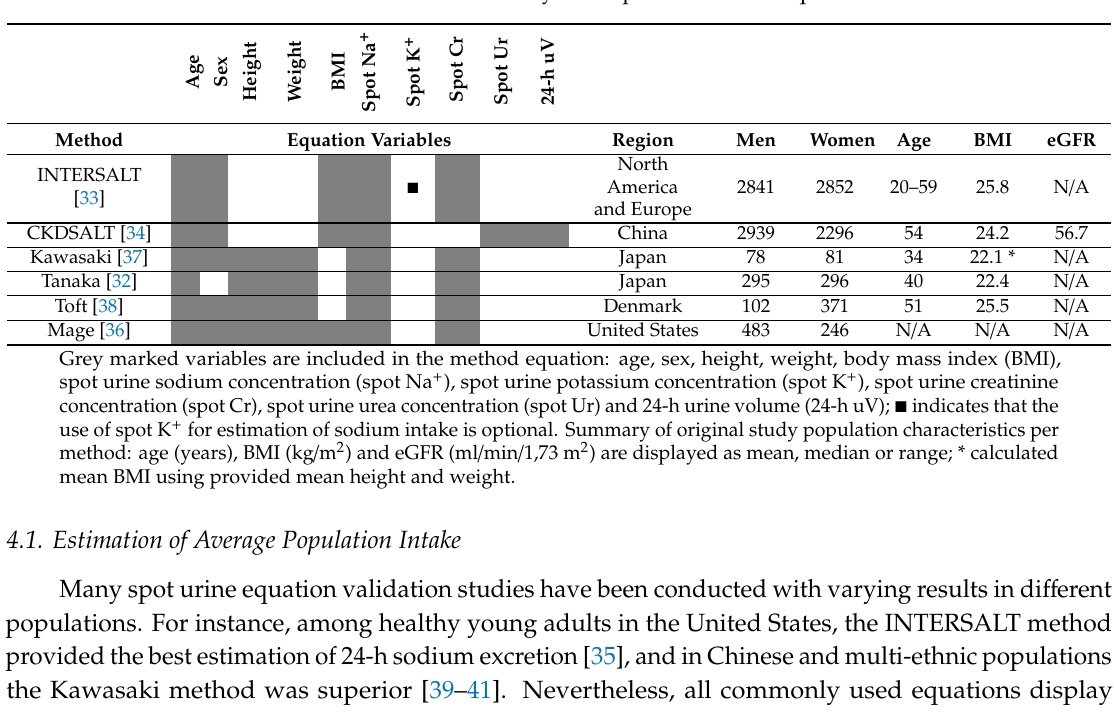
Table 2. Overview of commonly used spot urine based equations.